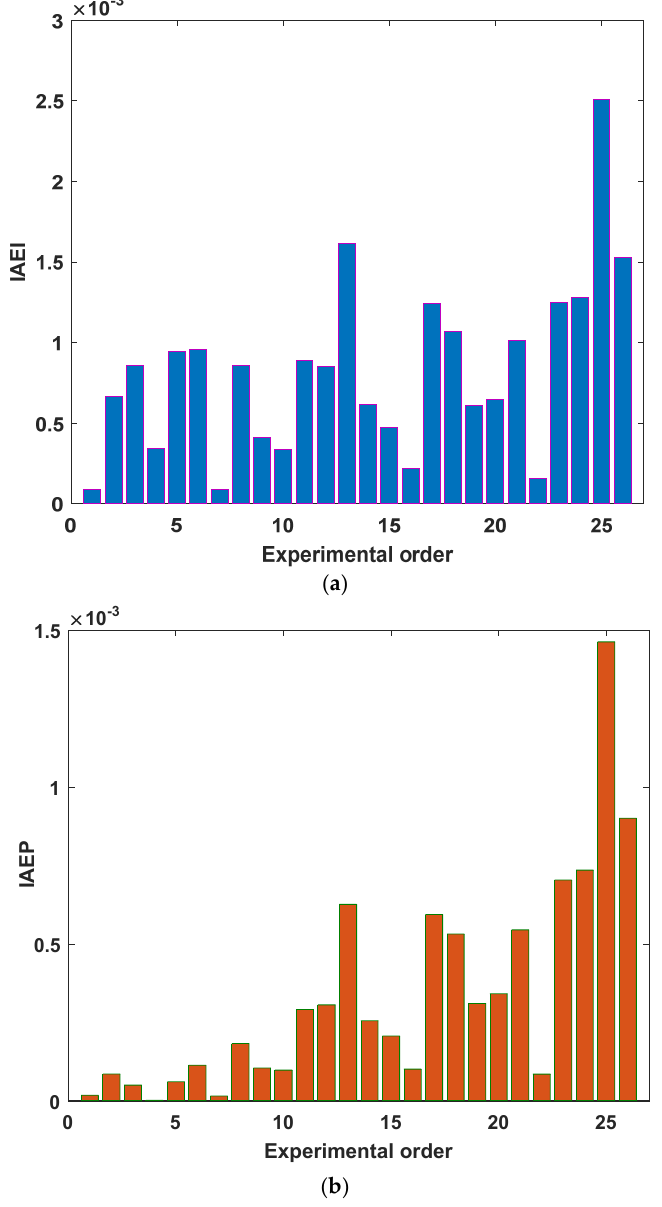
Figure 10. Individual absolute errors for current and power by the MECPO for SDM. ( a ) Individual absolute errors for current. ( b ) Individual absolute errors for power.